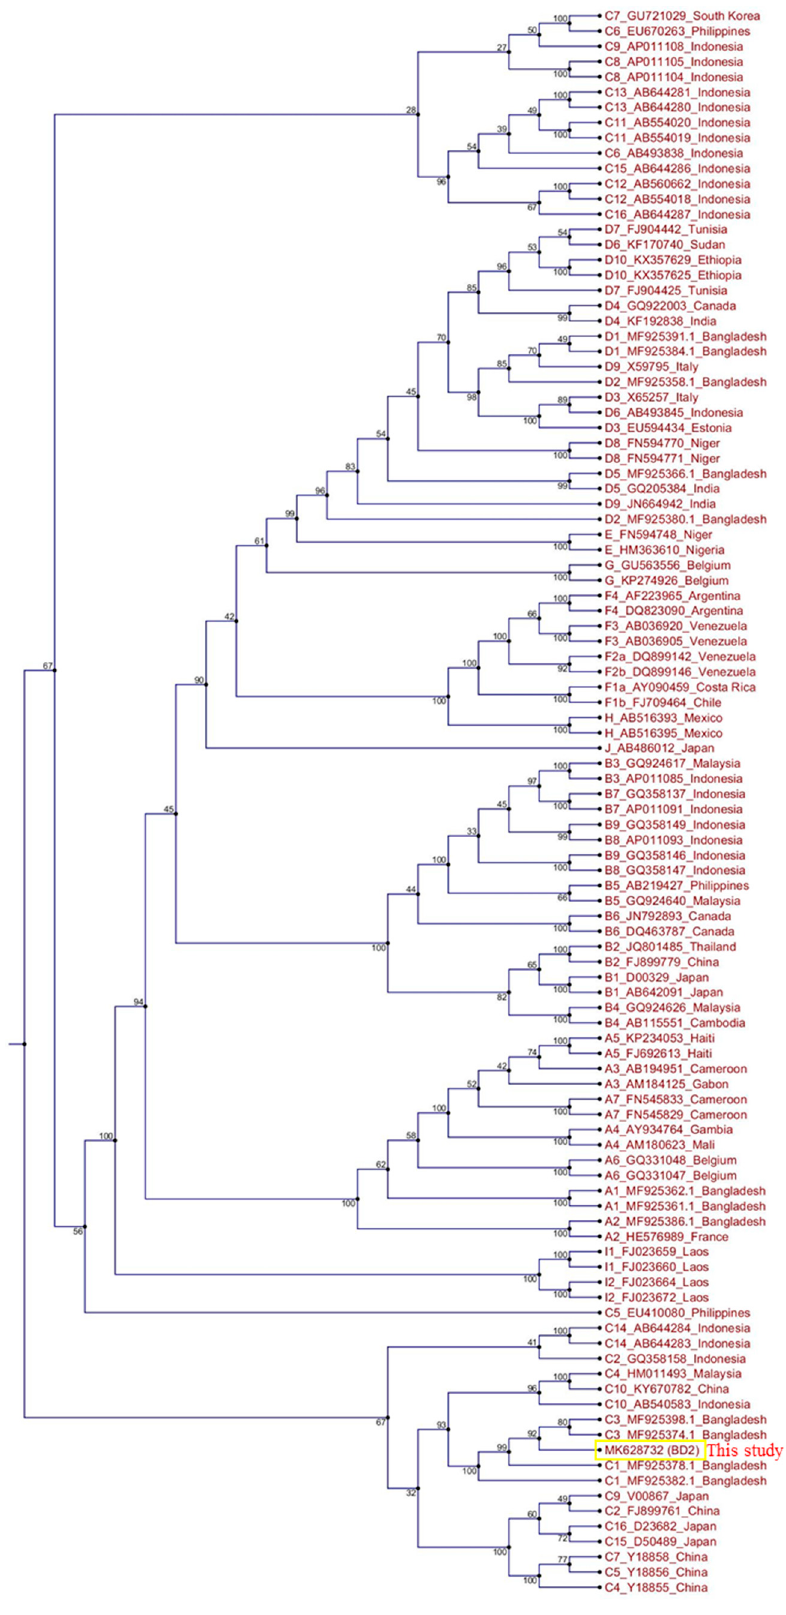
Figure 1. Phylogenetic tree analysis of hepatitis B virus (HBV) BD2 (MK628732). The full genome sequences of several HBV strains were extracted from GenBank, and a phylogenetic tree was constructed using CLC Sequence Viewer.